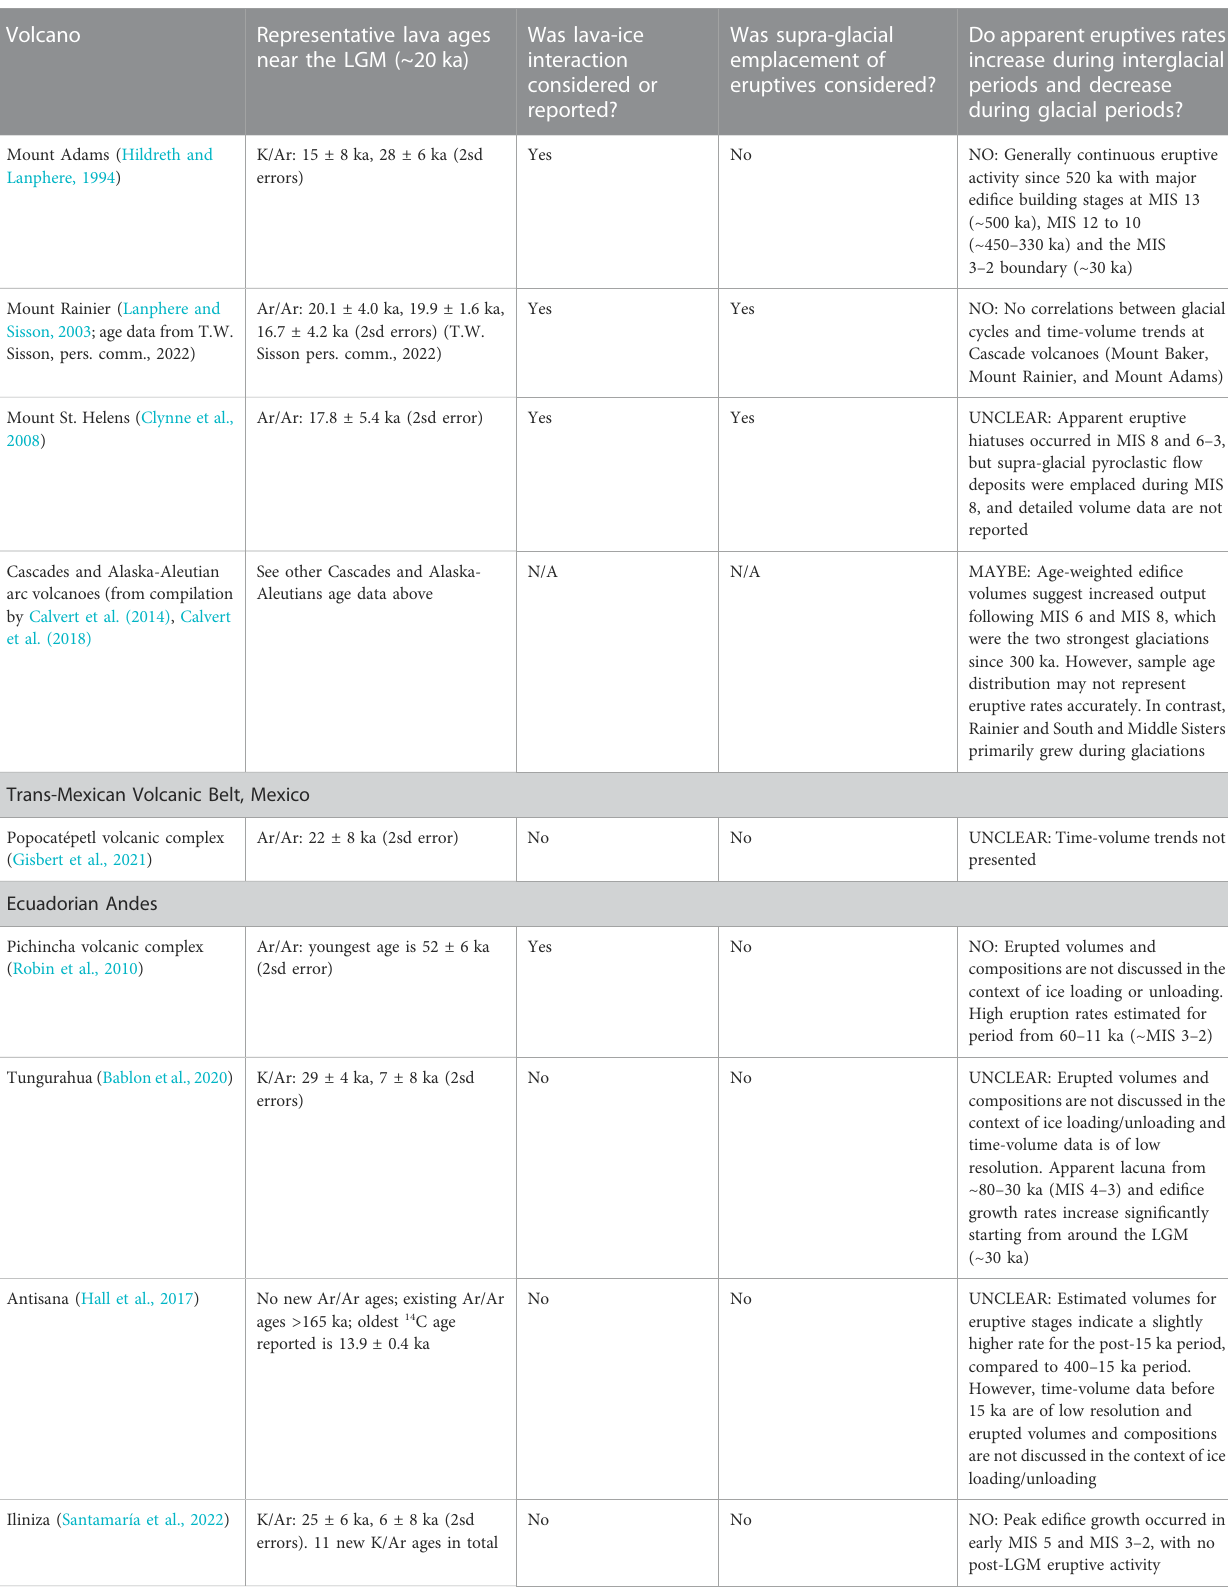
TABLE 2 ( Continued ) Summary of geochronological precision, preservation considerations, and time-volume correlations with climatic changes. The radiometric ages and other summarized information are from the references in Table 1, unless otherwise noted. Volcano Representative lava ages Was lava-ice Was supra-glacial Do apparent eruptives rates near the LGM (~20 ka) interaction emplacement of increase during interglacial considered or eruptives considered? periods and decrease reported? during glacial periods? Mount Adams (Hildreth and Lanphere, 1994)